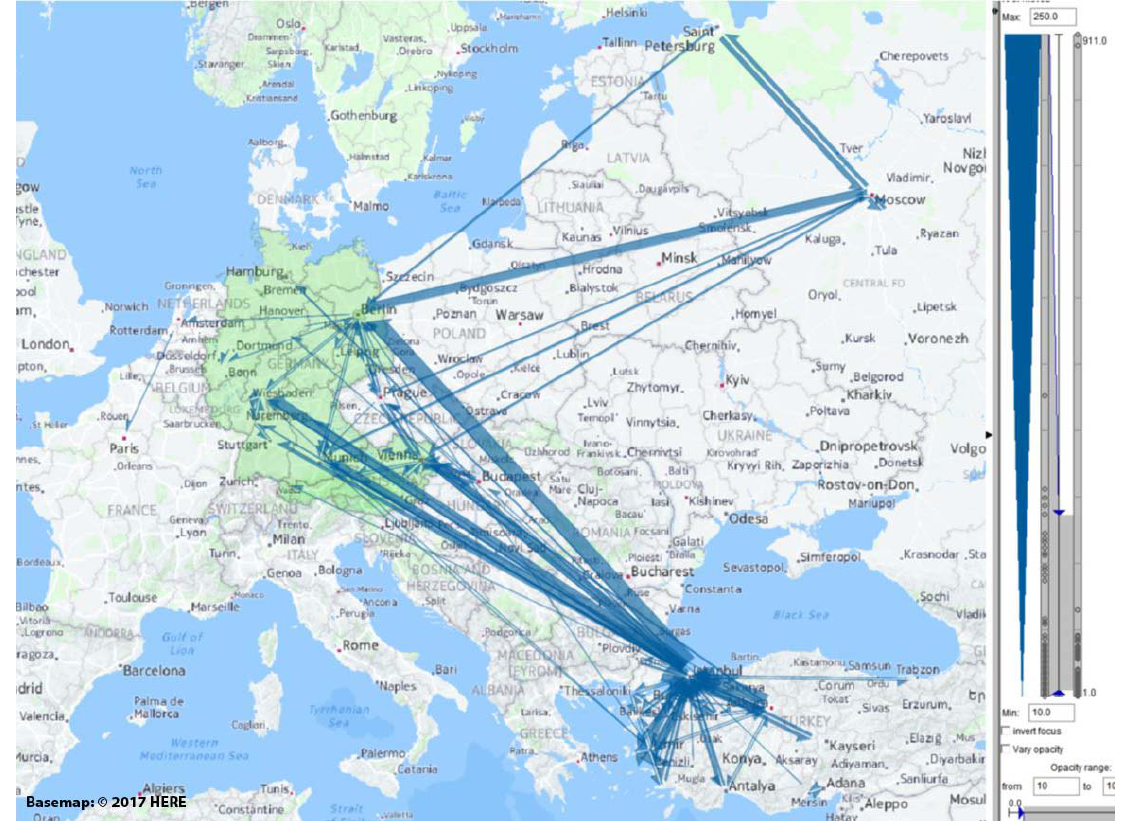
Figure 5. Generalized trajectories with at least one stop in Austria or Germany.